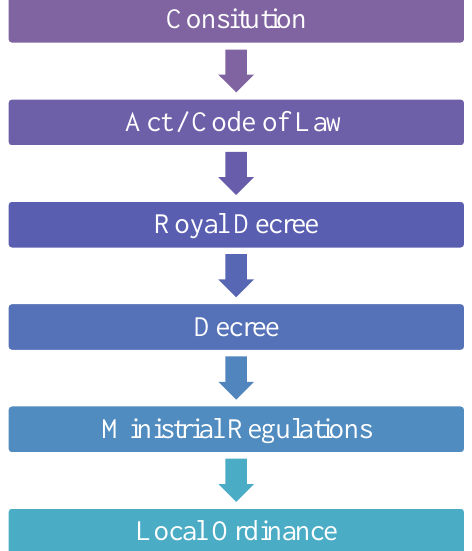
Figure 6. Hierarchy of Legal Framework in Thailand